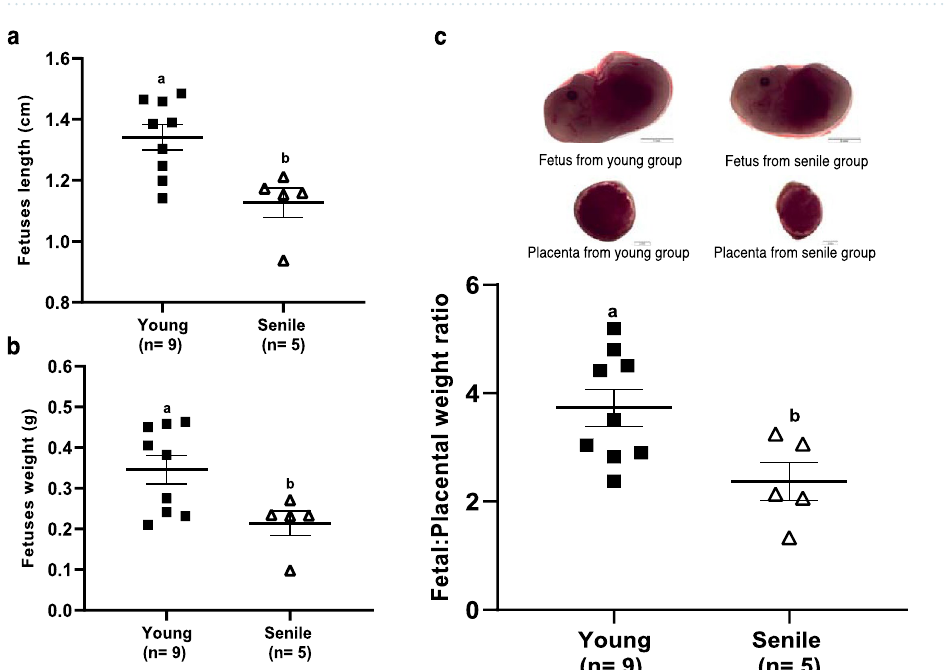
Figure 3. Fetal development at 16 days of gestation. Fetuses length ( a ) and weight ( b ), and fetal: placental weight ratio ( c ) of young and senile groups. We considered the average of the litters per male, 14 litters as experimental unit (5 litters in the senile group and 9 litters in the young group). The photos were performed with a megapixel digital color camera (Olympus LC30, Olympus ® , Munster, German) attached to a stereomicroscope (Olympus SZ61, Olympus ® , Tokyo, Japan) at ×8 magnification. Different superscript letters in each bar represent p < 0.05, as indicated by statistical